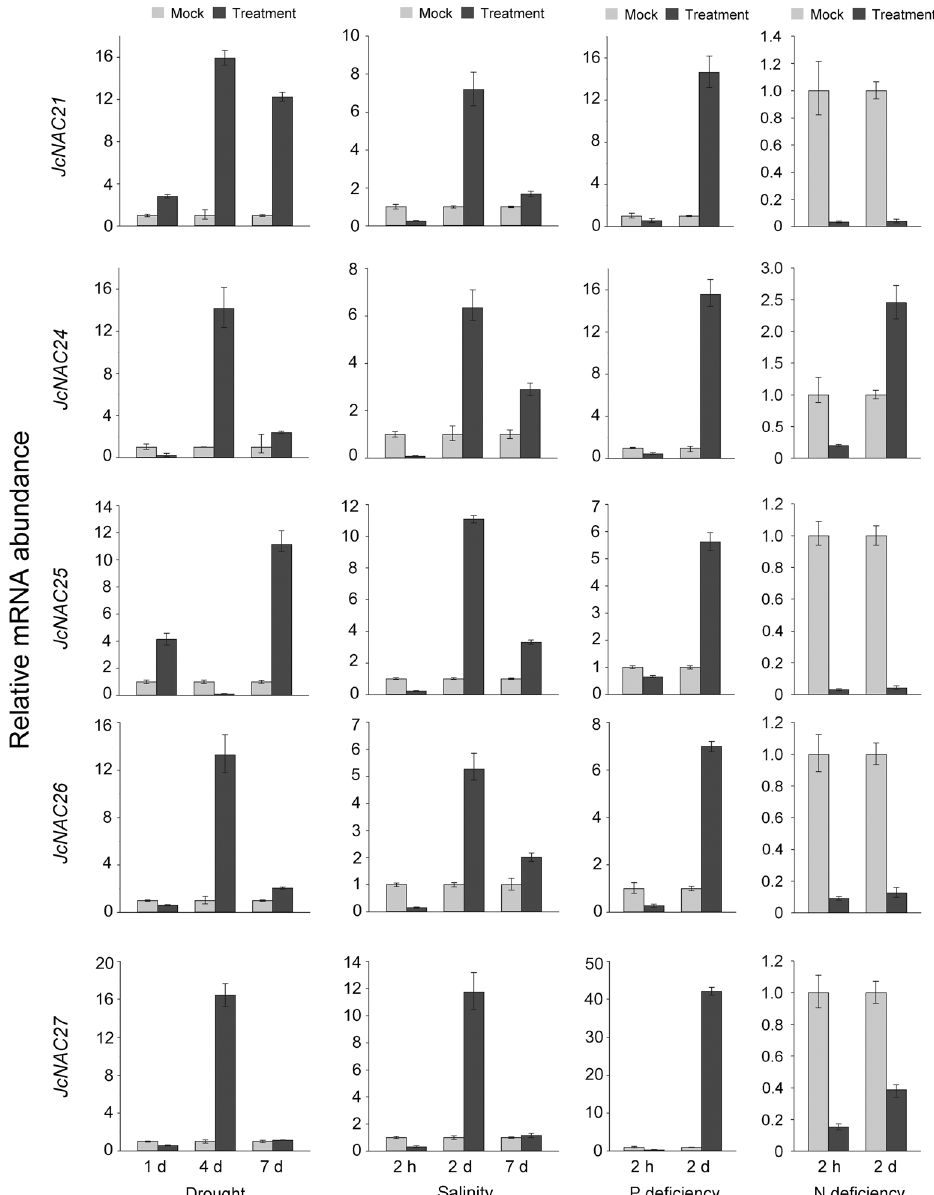
Fig 5. Expression analysis of selected JcNAC genes. Results of quantitative PCR analysis of transcripts in roots, the expression level of each gene under common condition sampled as mock. The relative expression was normalized to the reference gene JcActin as an internal control. The bars show standard deviations of the repeats. Each assay was run in triplicate for two independent biological